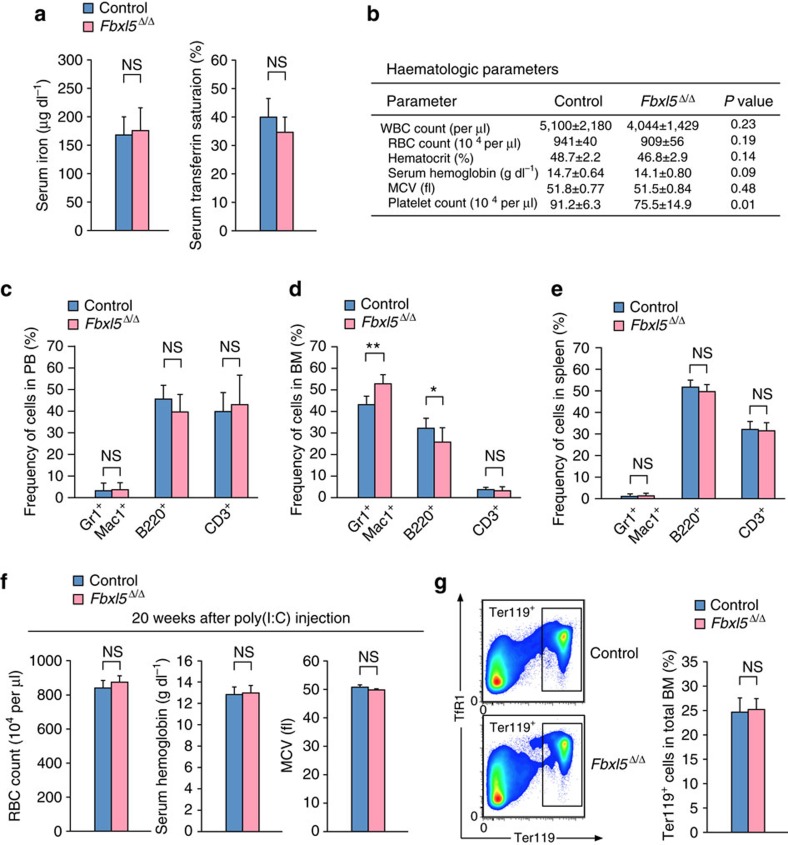
Cellular iron overload has only a small effect on differentiated cells.(a) Serum iron concentration (left) and transferrin saturation (right) in Fbxl5Δ/Δ or control mice (n=9). (b) Haematologic parameters in Fbxl5Δ/Δ or control mice (n=9). WBC, white blood cell; RBC, red blood cell; MCV, mean corpuscular volume. (c–e) Frequency of differentiated cells (Gr1+Mac1+ myeloid cells, B220+ B cells and CD3+ T cells) in PB (n=9) (c), BM (n=9) (d) and the spleen (n=6) (e) of Fbxl5Δ/Δ or control mice. (f) Haematologic parameters related to erythropoiesis in Fbxl5Δ/Δ or control mice at 20 weeks after the last poly(I:C) injection (n=4). (g) Representative flow cytometric analysis of Ter119 on the surface of BM cells as well as the frequency of Ter119+ erythroid cells in BM for Fbxl5Δ/Δ or control mice (n=3) at 4 weeks after poly(I:C) injection. Data are means+s.d. *P<0.05, **P<0.01 (Student’s t-test); NS, not significant.